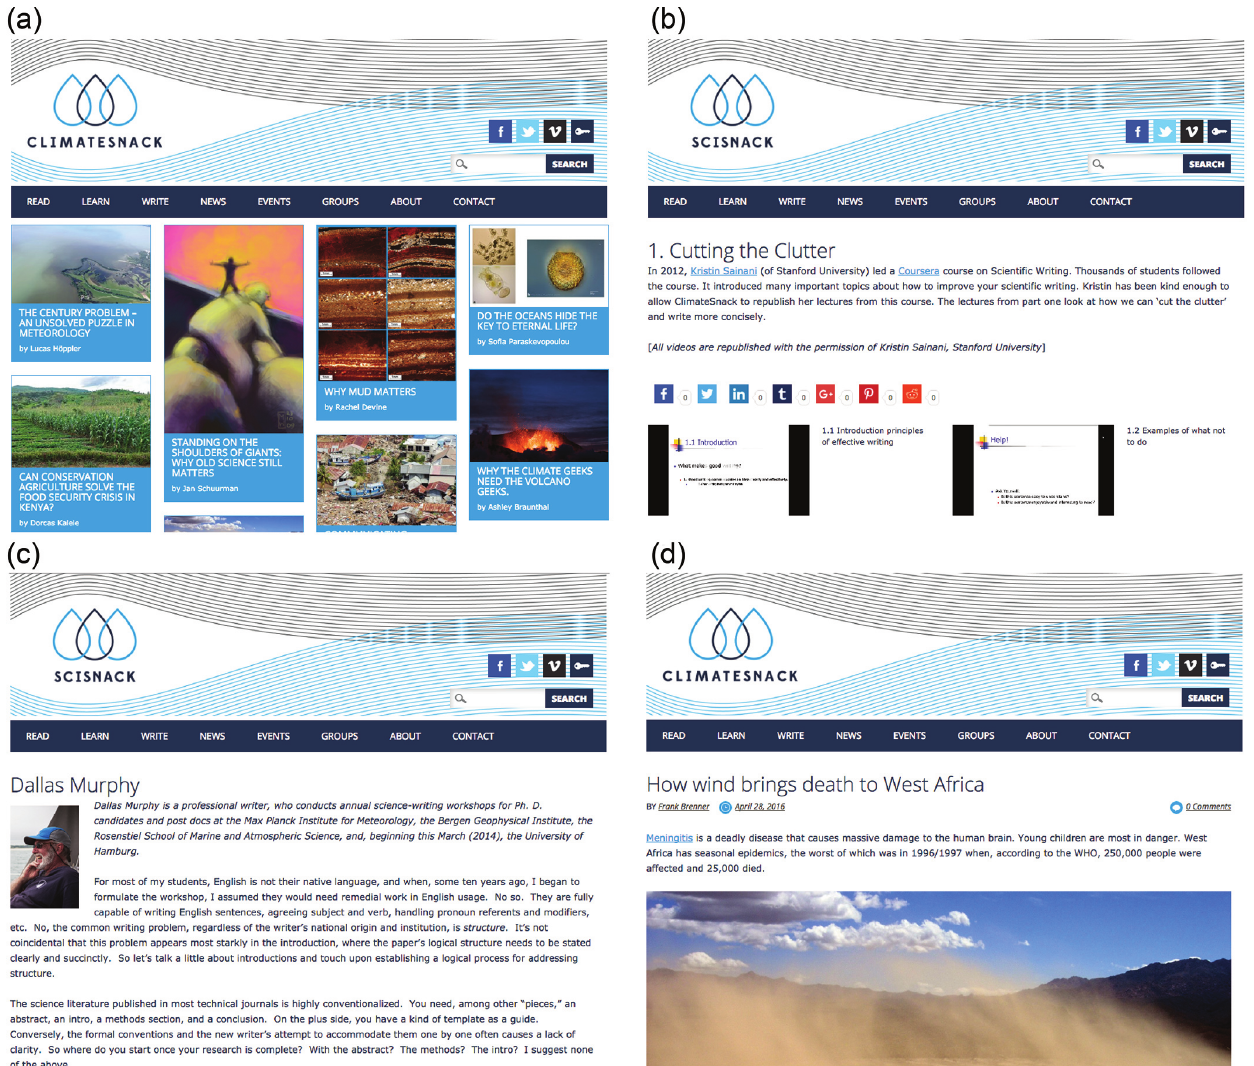
Figure 3. Screenshots from the ClimateSnack/SciSnack website showing (a) the home page, (b) one of the chapters from the online writing course from Kristin Sainani, Stanford University, (c) expert advice from author Dallas Murphy, and (d) an example